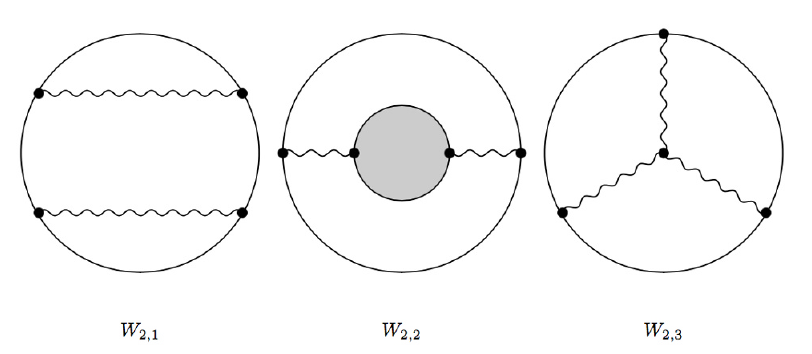
Figure 2 . Order (cid:21) 2 contributions to the standard Wilson loop. The middle diagram contains the full self-energy 1-loop correction in SYM theory (with vector, ghost, scalar and fermion (cid:12)elds in the loop). For the Wilson-Maldacena loop there are additional diagrams with scalar propagators instead of some of the vector